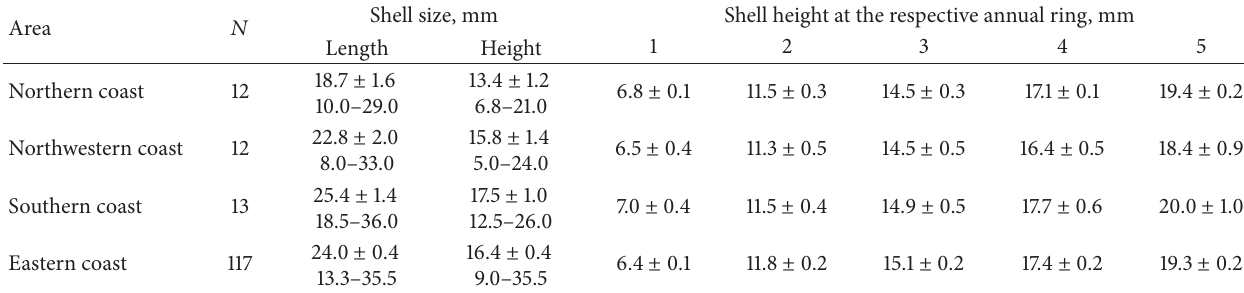
Table 1: Size limits and growth rates of the clam Ruditapes bruguieri along the Jeju Island coast, South Korea. The mean values ± standard error of the mean and min–max limits for shell parameters are